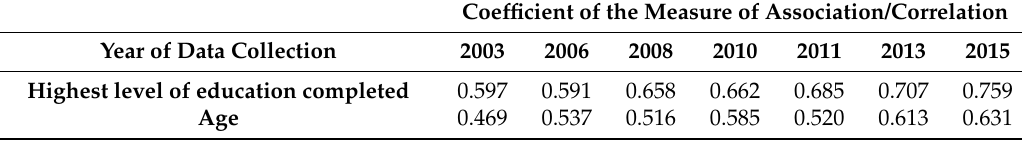
Table 2. Coefficients of association/correlation with Internet use in previous